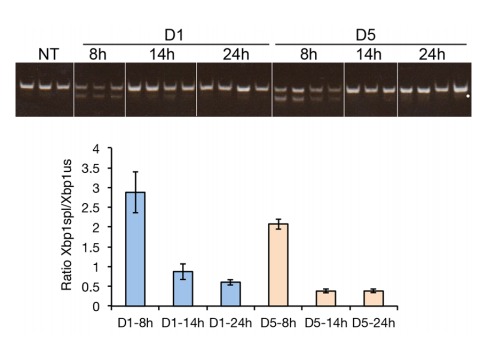
DOI:
http://dx.doi.org/10.7554/eLife.20390.016